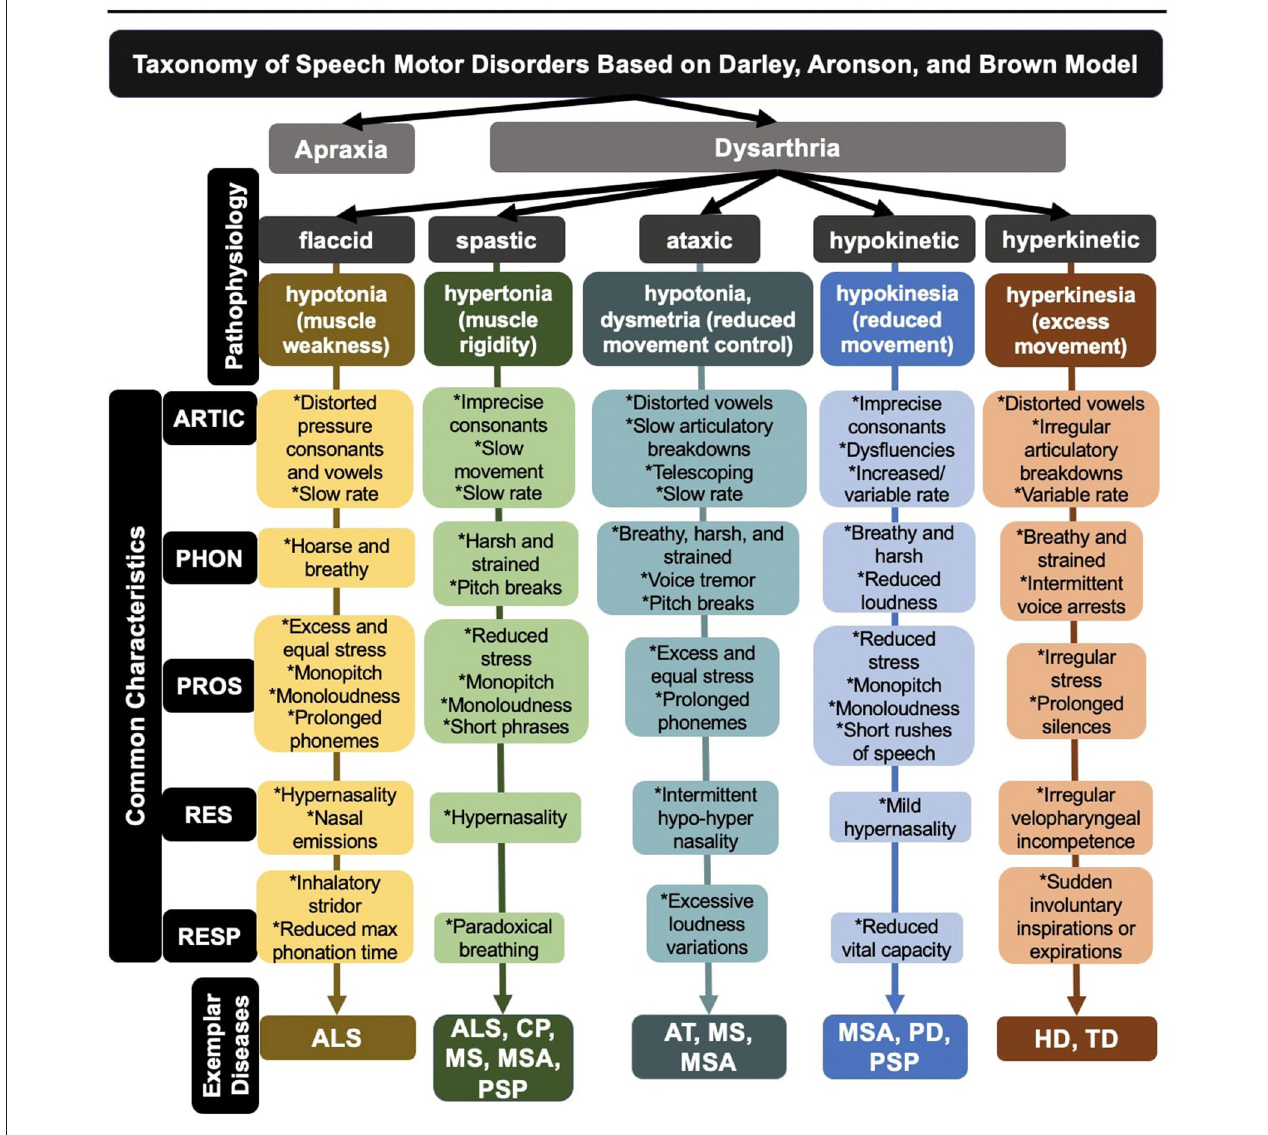
FIGURE 1 | Breakdown of dysarthria subtypes within a widely used taxonomy of speech motor disorders. ALS, amyotrophic lateral sclerosis; CP, cerebral palsy; AT, ataxia; HD, Huntington’s disease; MS, multiple sclerosis; MSA, multiple systems atrophy; PD, Parkinson’s disease; PSP, progressive supranuclear palsy; TD, tardive dyskinesia; ARTIC, articulation; PHON, phonation; PROS, prosody; RES, resonance; RESP,